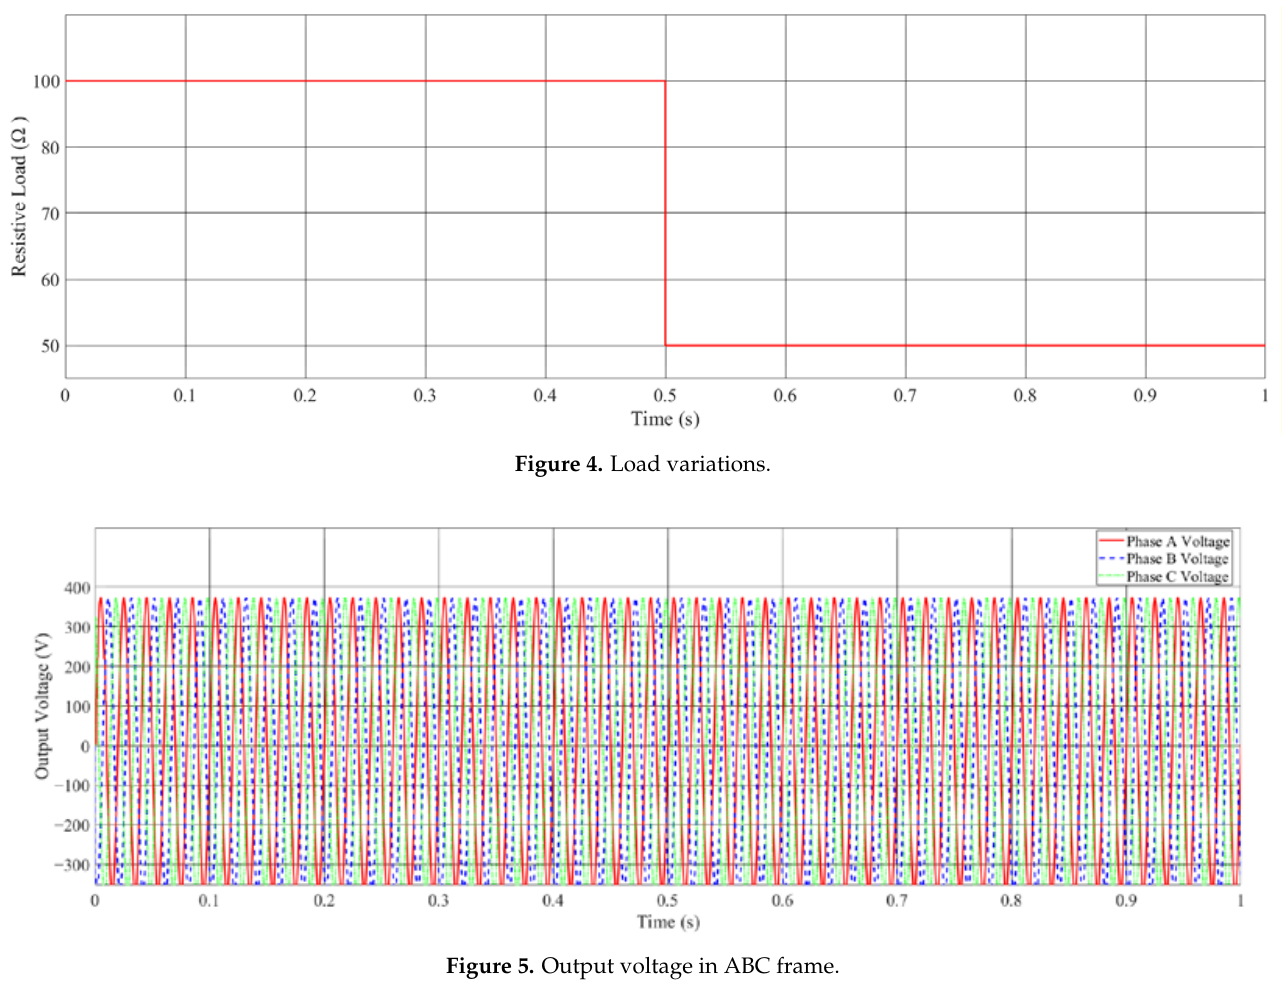
Figure 5. Output voltage in ABC frame.